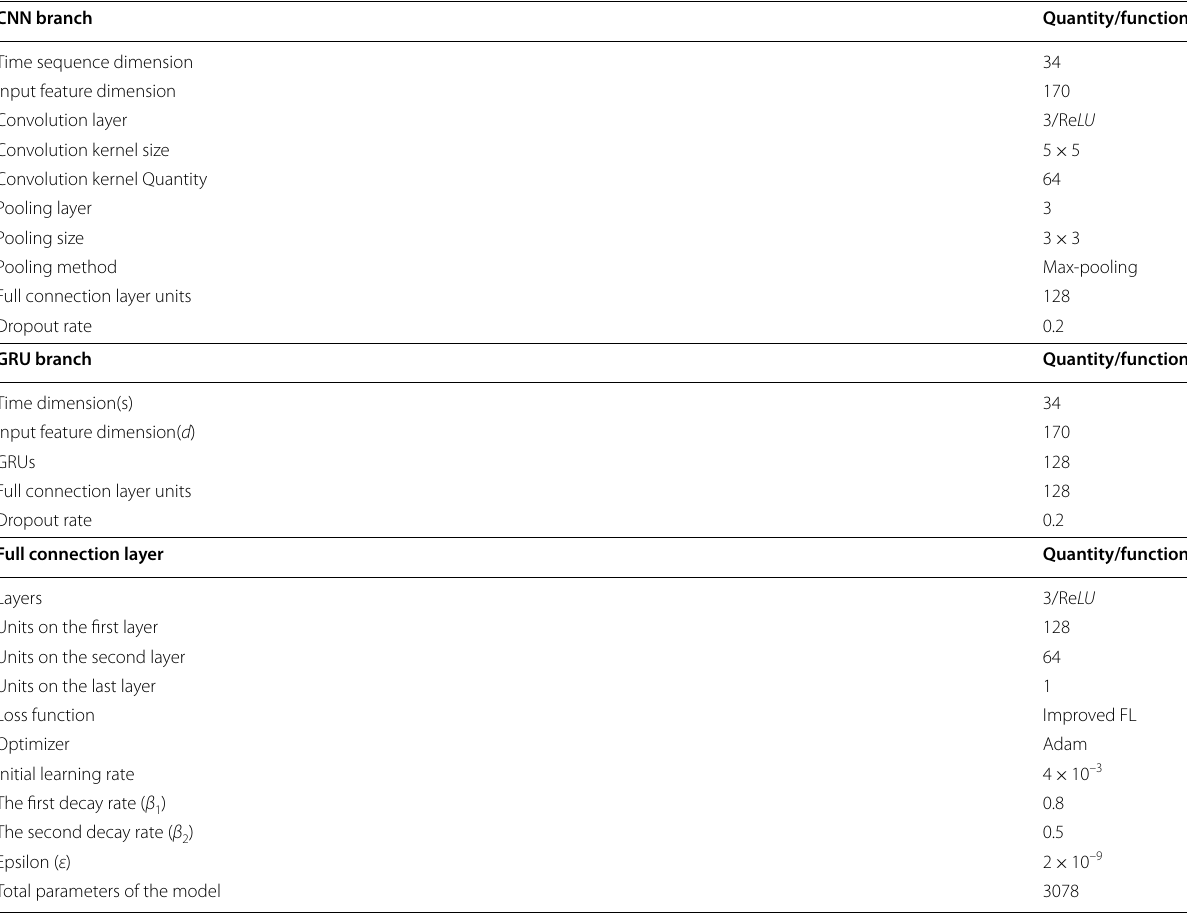
GRU on the IEEE 39-bus +